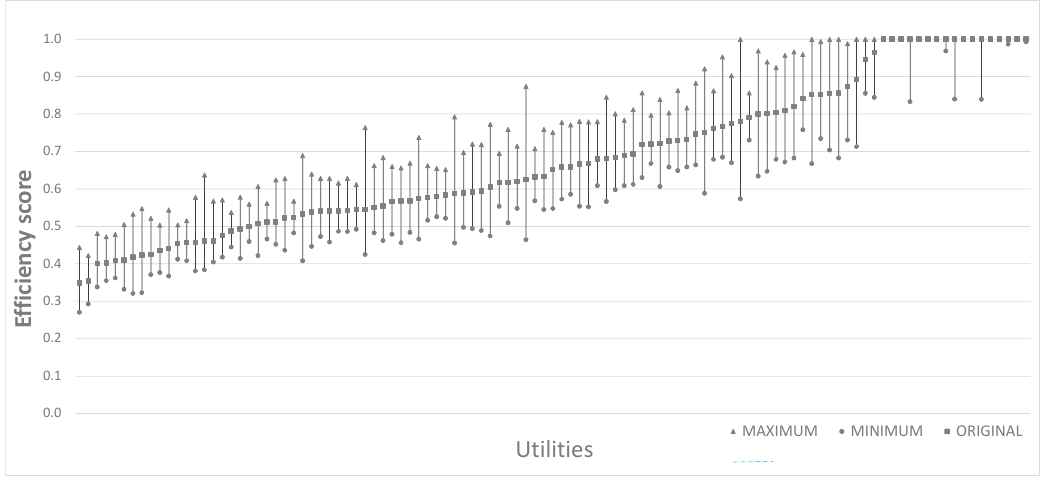
Figure 2. Minimum, maximum, and original data envelopment analysis (DEA) results for the reduced sample